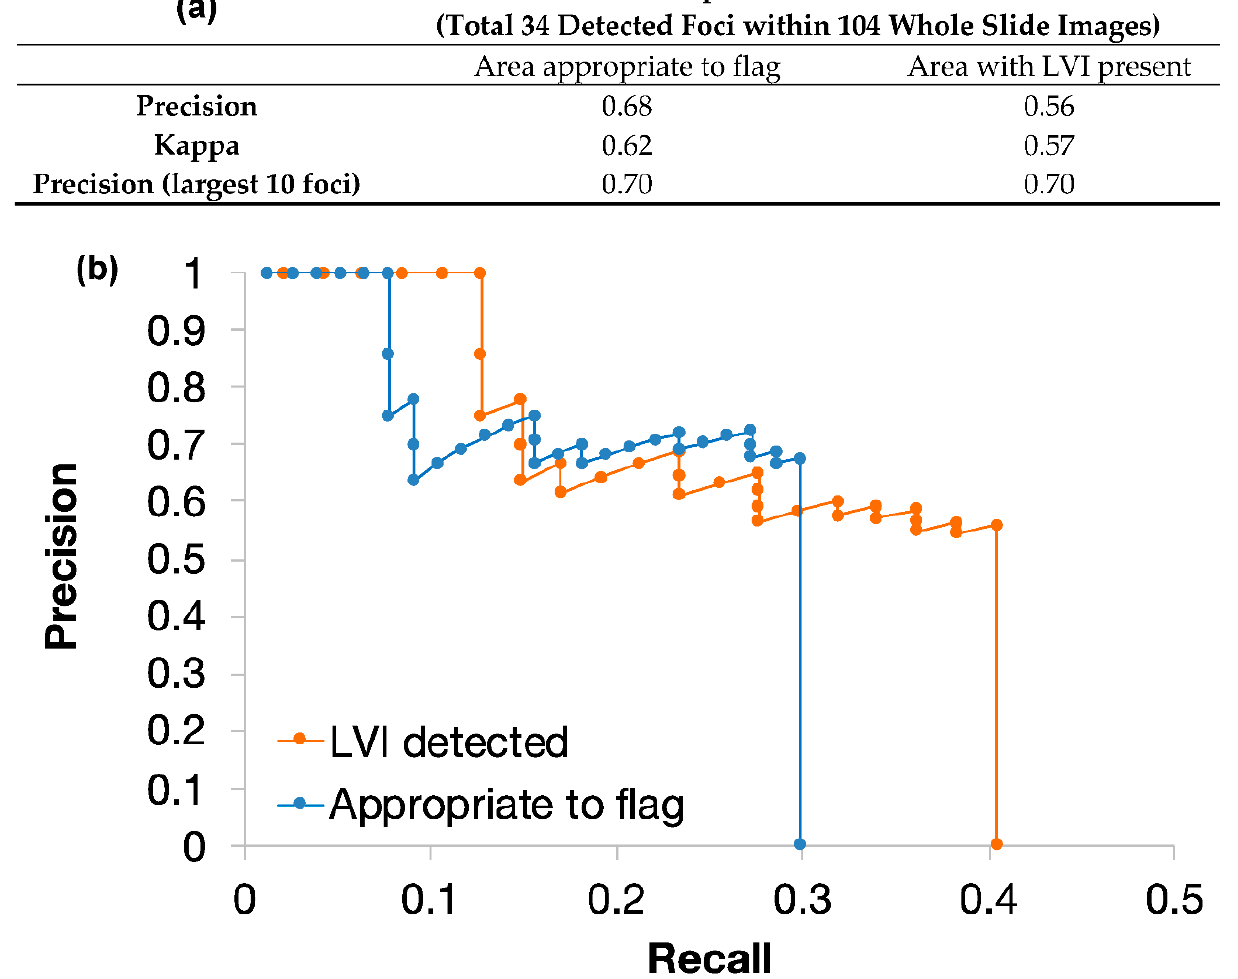
Figure 4. ( a ) Overall precision of the deep-learning classifier following three expert reviews of each identified focus and agreement between experts when classifying into areas appropriate for review or areas of definite LVI. ( b ) Precision-recall curves showing performance of the deep-learning classifier ordered by focus size (a larger focus size indicating a higher number of adjacent high probability pixels).